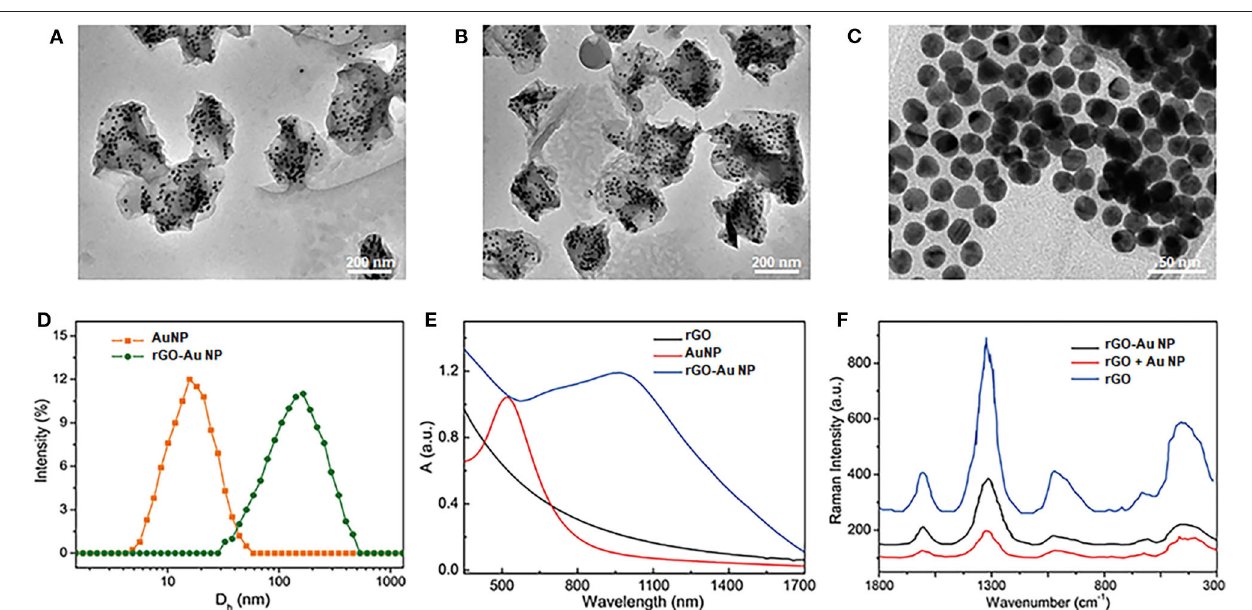
FIGURE 1 | Characterization of the theranostic rGO-AuNP nanocomposite. (A–C) TEM images of rGO-AuNP at different densities and magnifications. (D) Hydro dynamic distribution of the AuNPs and rGO-AuNP. (E) UV-vis spectra of the rGO-AuNP. (F) SERS spectra of the rGO, the mixture of AuNPs and rGO, and rGO-AuNP complex